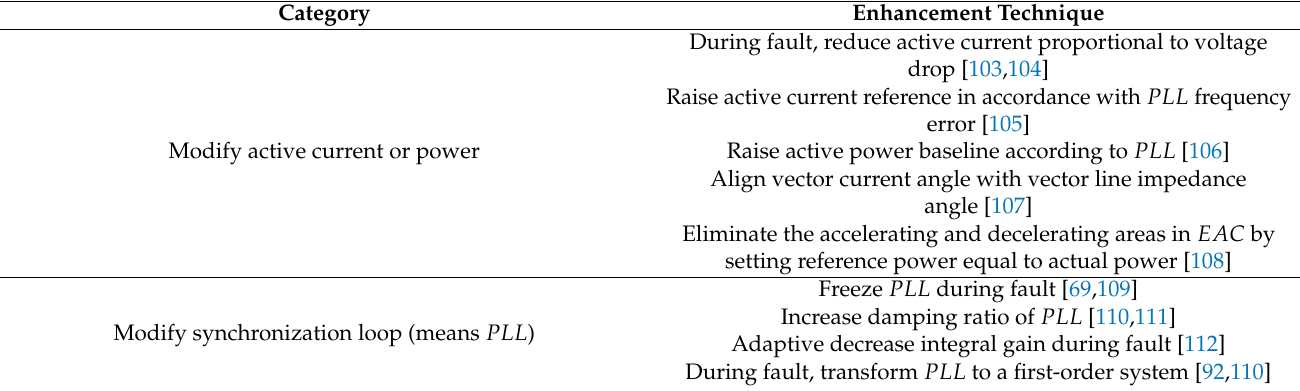
Table 1. Transient stability enhancement techniques for GFL